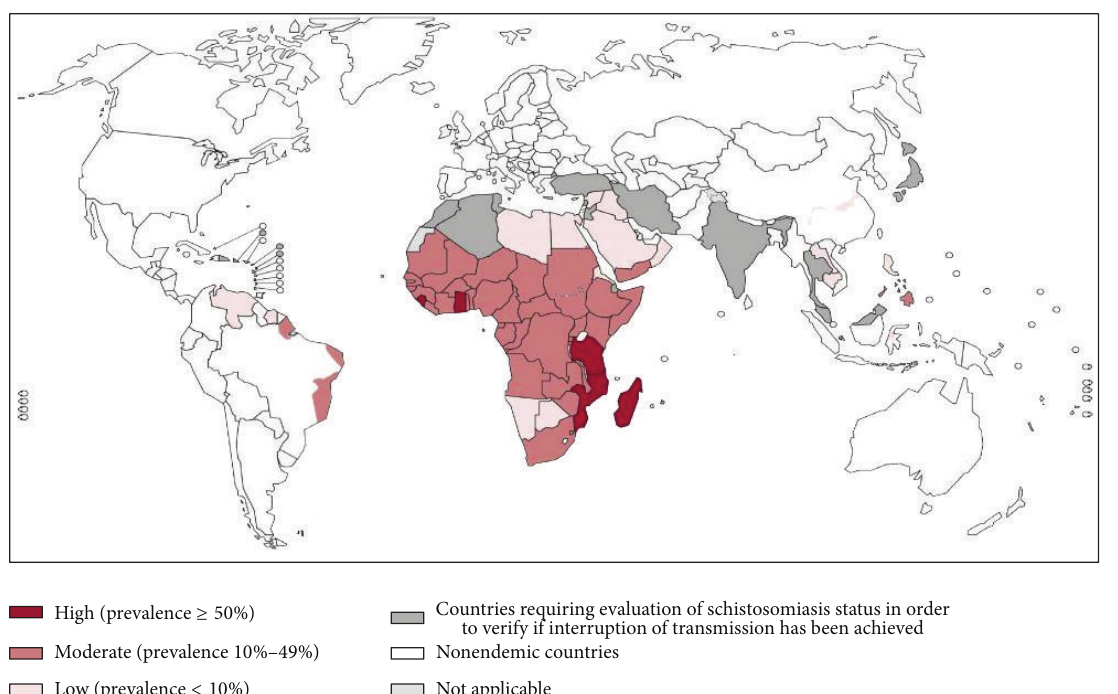
Figure 1: Distribution of schistosomiasis, worldwide, 2011 [9].